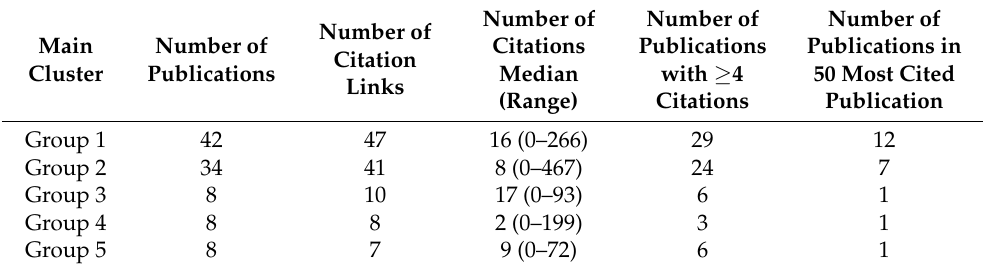
Table 5. Information about the citation network of the top five groups.